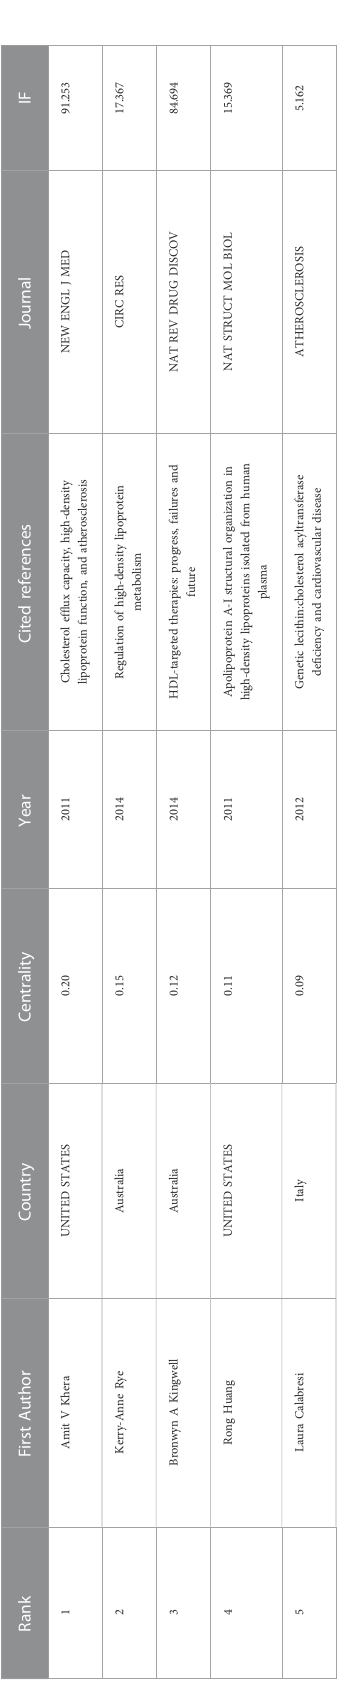
activated by apoA-I could esterify plasma cholesterol and